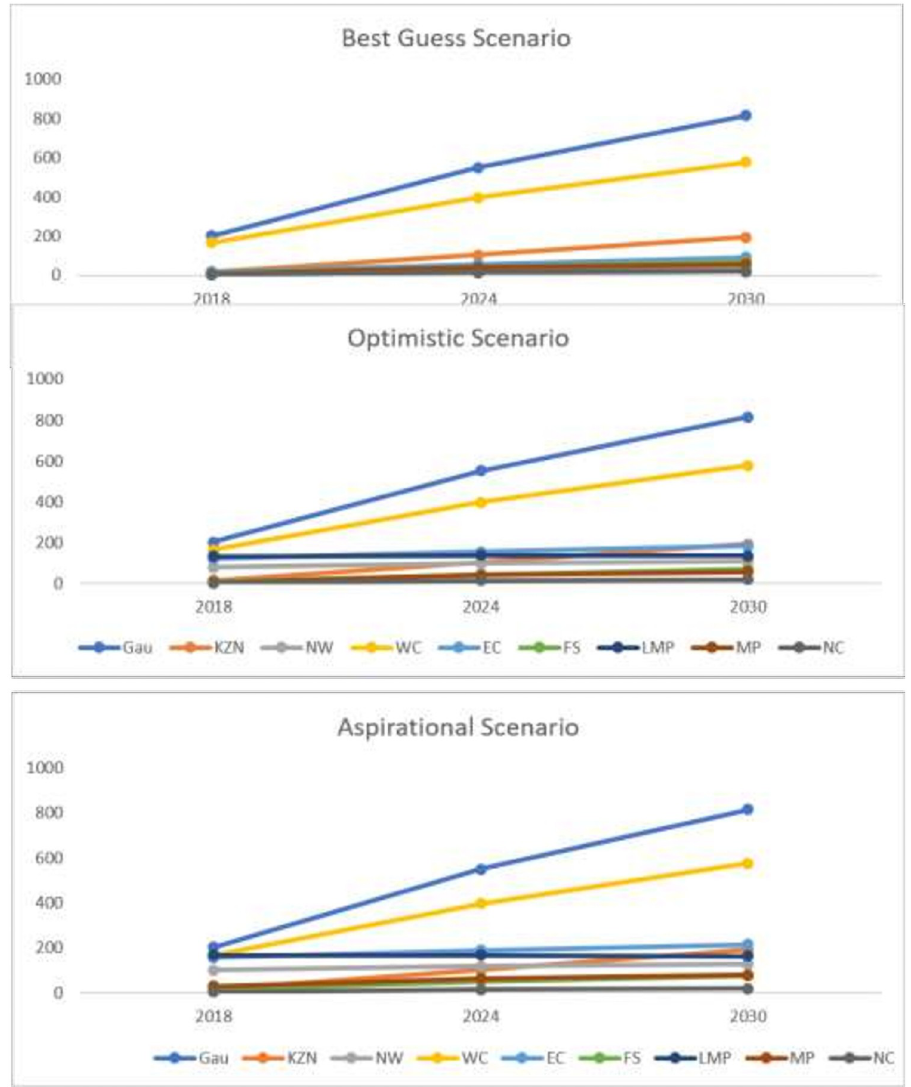
Fig 4. National shortfall for dentists and dental specialists based on three scenarios (up to 2030). Gauteng (GAU); KwaZulu-Natal (KZN); North West (NW); Western Cape (WC); Eastern Cape (EC); Free State (FS); Limpopo (LMP); Mpumalanga (MP); Northern Cape